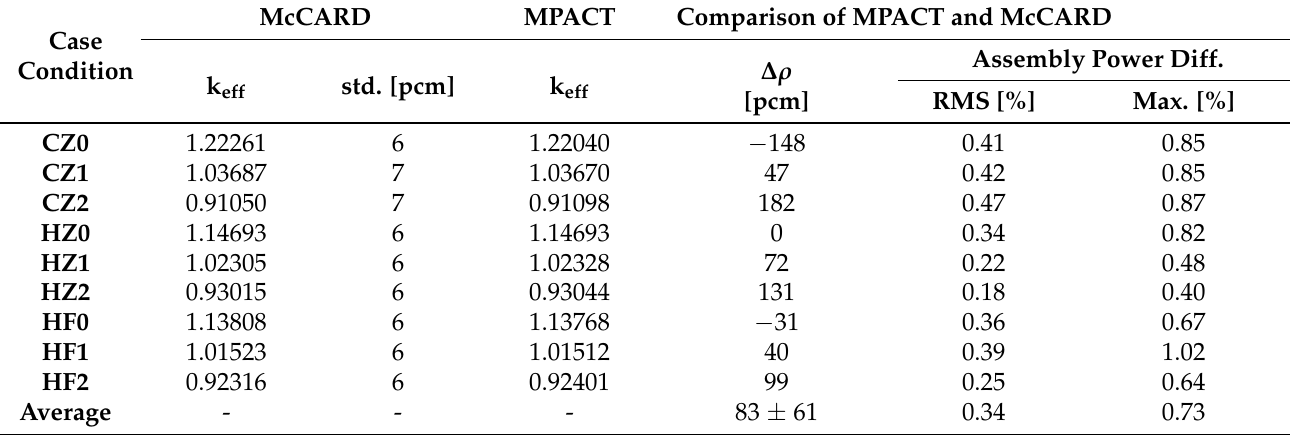
Table 6. Summary of 2-D core results and comparison between MPACT and